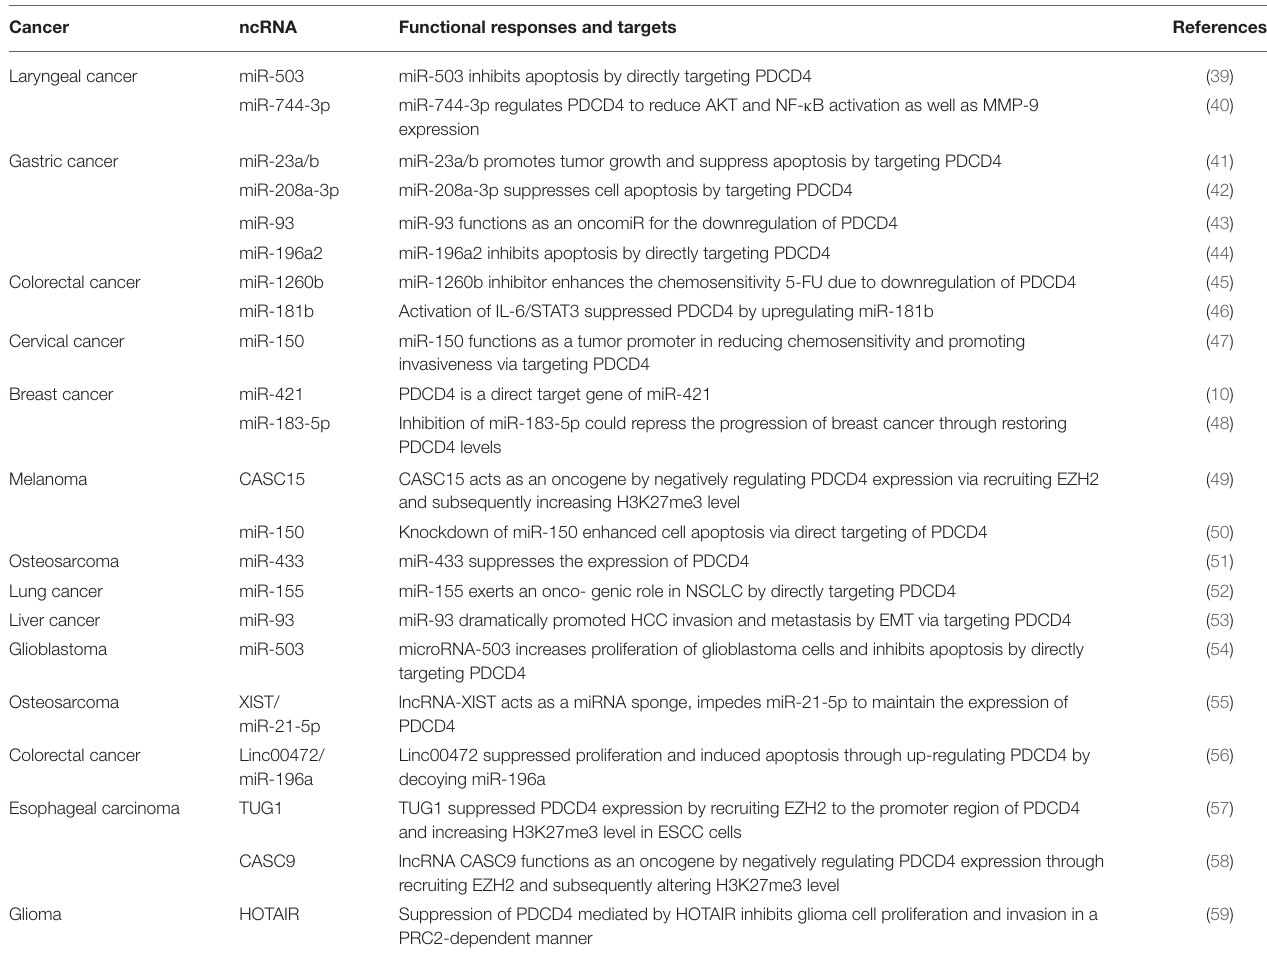
TABLE 1 | The summary of ncRNA that regulate PDCD4 in different cancers and inflammatory